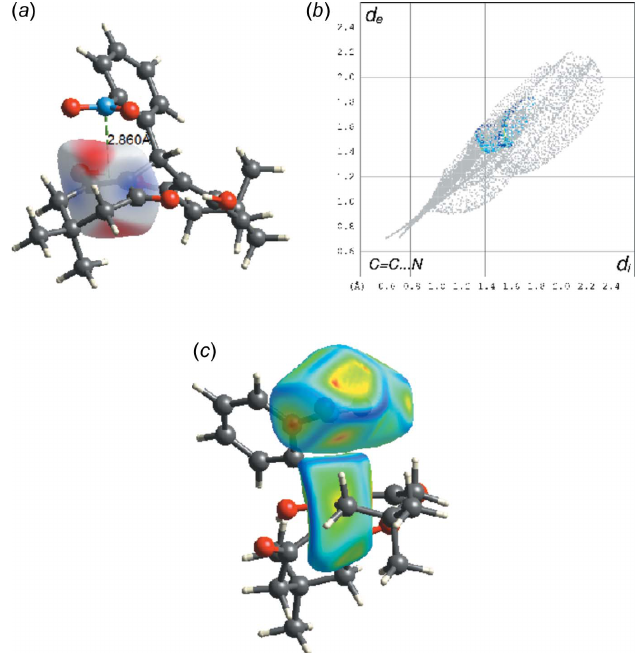
Figure 2 ( a ) View of the three-dimensional Hirshfeld surface of C16—C17 mapped over electrostatic potentials, over the range of (cid:5) 0.0221 to 0.9216 arbitrary units. ( b ) The two-dimensional fingerprint plot for the C=C (cid:2)(cid:2)(cid:2) N interaction. ( c ) The Hirshfeld surfaces of NO 2 and C16—C17 mapped over curvedness.